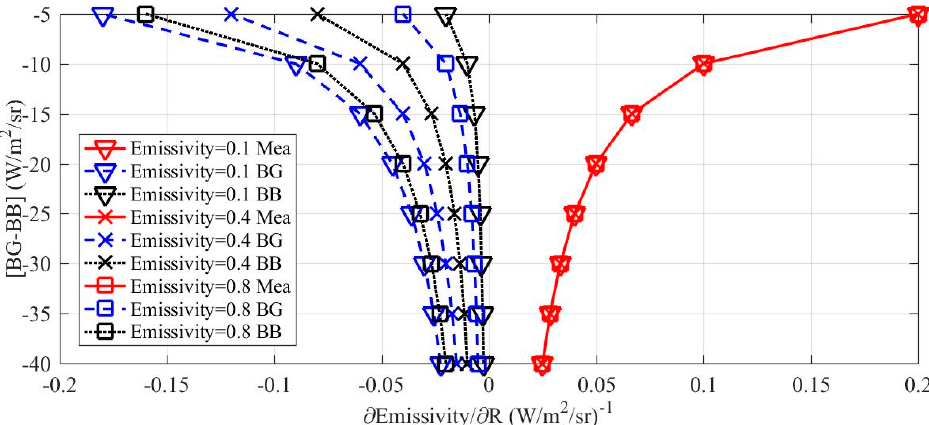
Figure 2. Effective emissivity uncertainty per radiance unit error on the measurement, the clear sky simulation, and the simulation of sky with blackbody